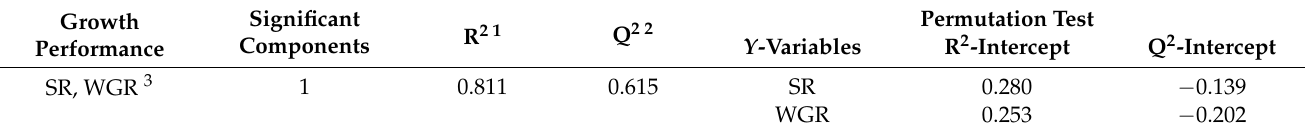
Table 8. Partial least-squares regression (PLS) models for growth performance of Nile tilapia.